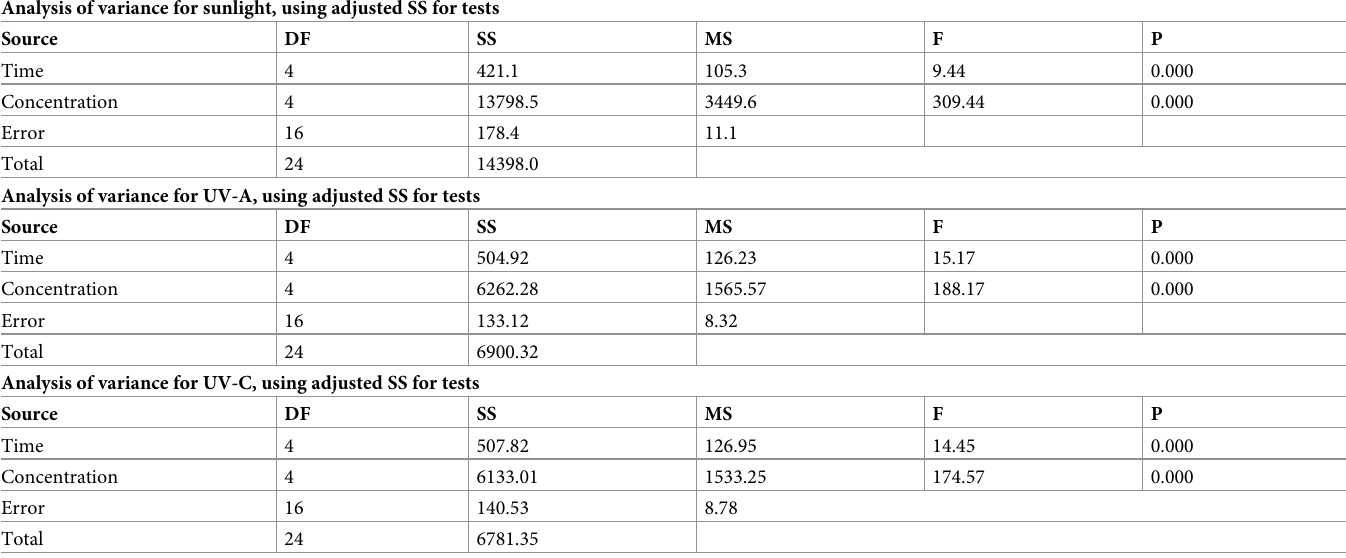
Table 5. Repeated measures MANOVA to identify significant variations in degradation with different light effects. Analysis of variance for sunlight, using adjusted SS for